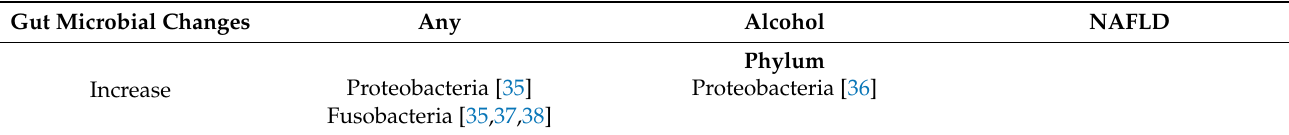
Table 1. The gut dysbiosis profiles in